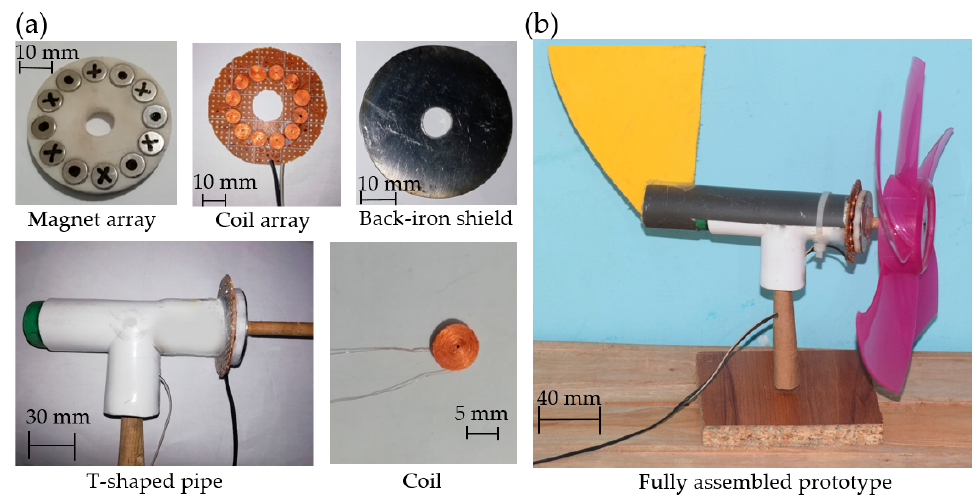
Figure 3. Photographs of the ( a ) harvester components before assembly and ( b ) a fully assembled prototype energy harvester. Table 1. Geometric parameter of each component of the EMWEH prototype.